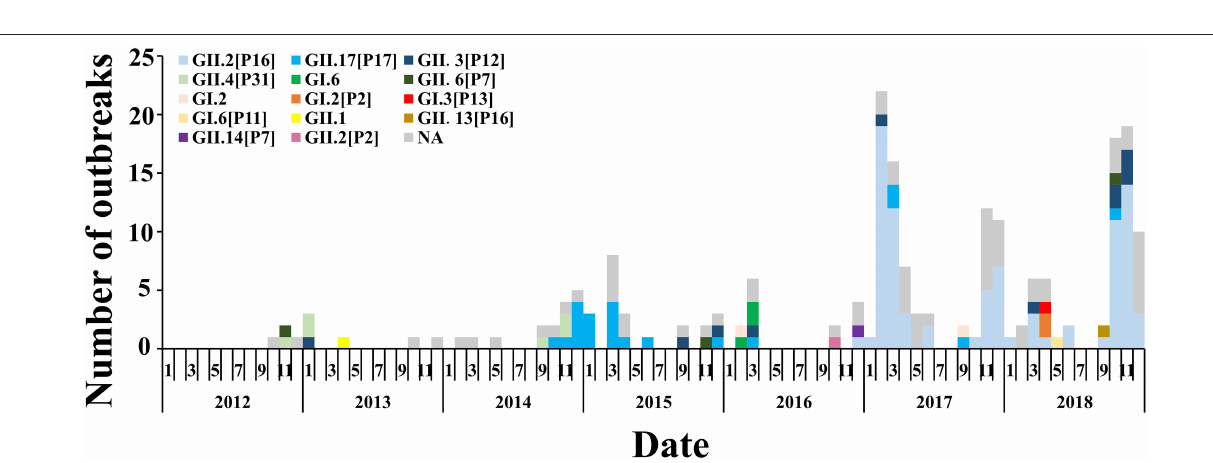
higher compared to urban areas, which may be related to poor sanitation in rural areas and the untimely adoption of control